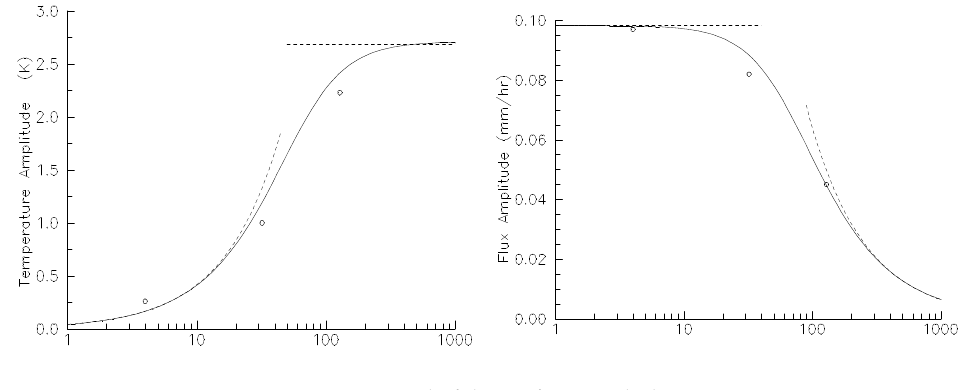
Figure 5. Amplitude of ( left ) the air surface temperature and ( right ) the surface energy flux against the forcing period of the surface wind 2π/ω, where the energy flux takes the unit of the equivalent water evaporation. The circles denote the CRM results, and the solid lines denote the analytic results of Equation (8). The dashed lines over small period denote the active mode where the difference between the sea surface entropy and the air surface entropy is fixed; the dashed lines over long periods signify the passive mode where the surface entropy flux is fixed.